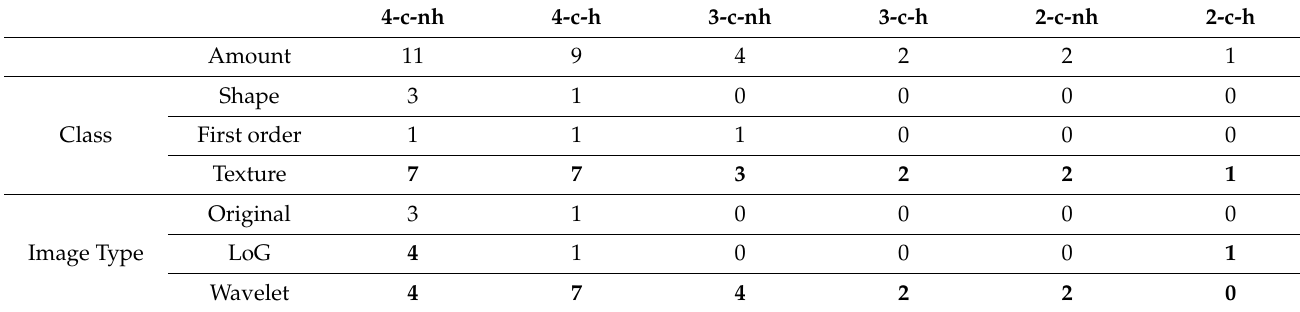
Table 5. Selected features with a frequency greater than or equal to 80%.